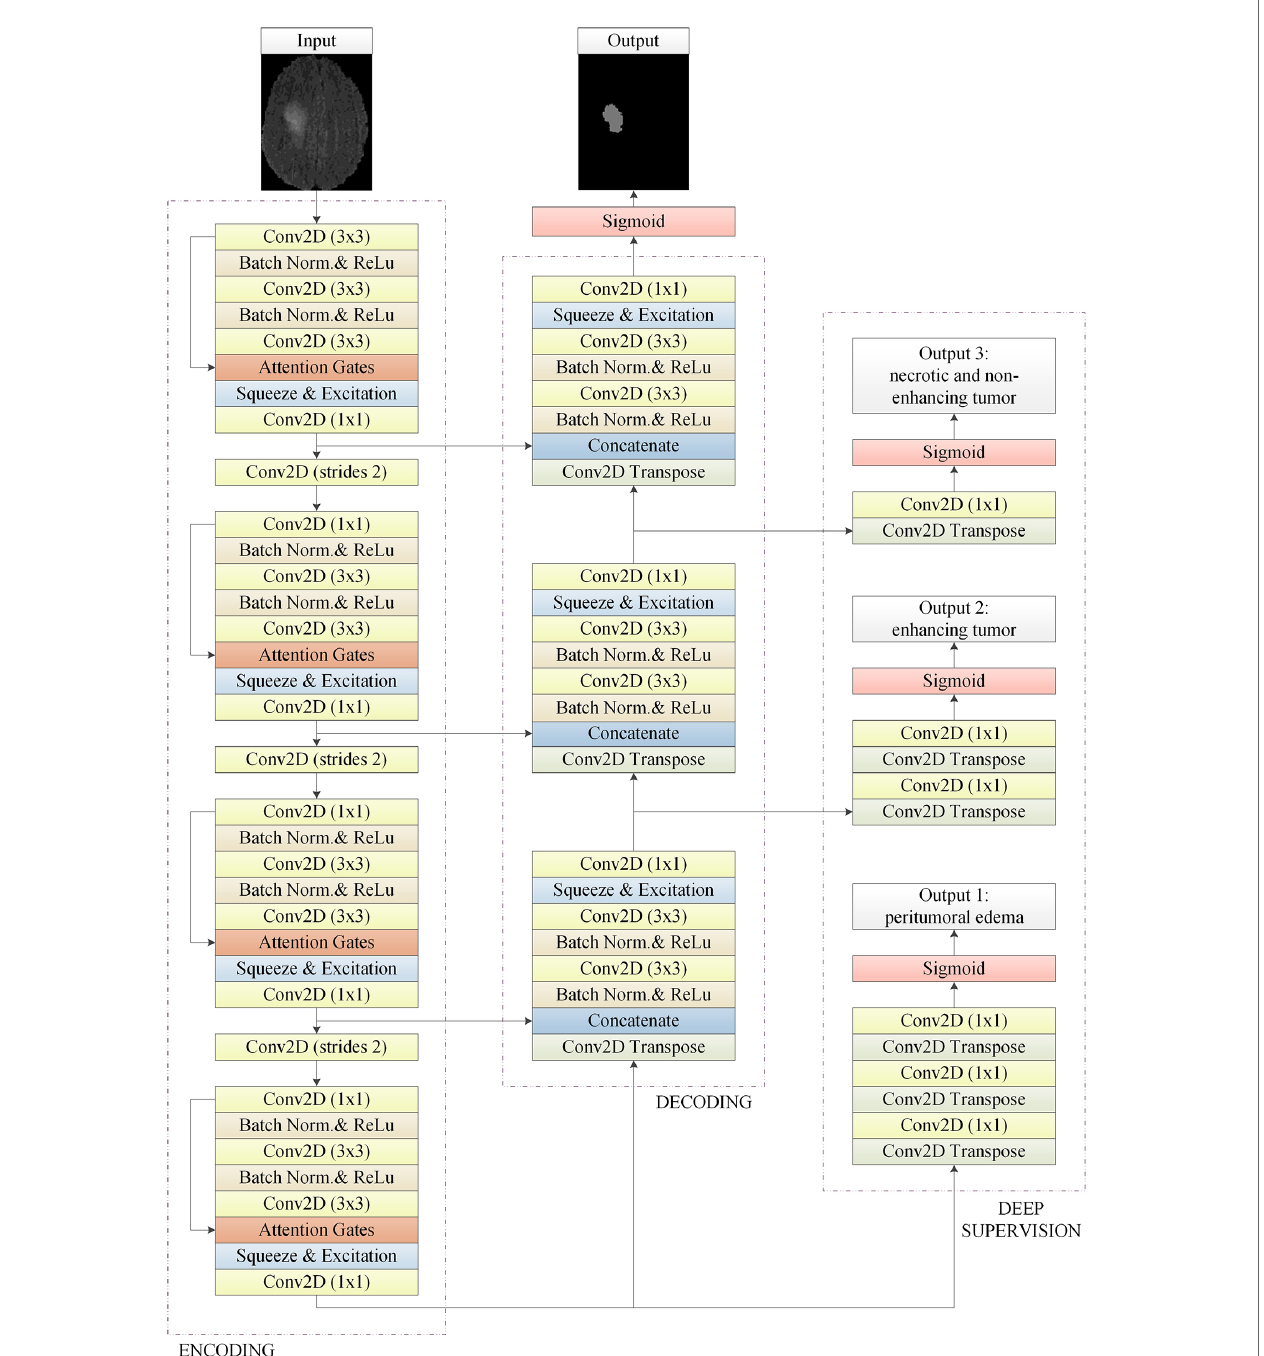
FIGURE 1 | The basic 2D convolutional neural network for brain tumor segmentation. It consists of encoding, decoding, and deep supervision. Our approach is an end-to-end network, the input of the network is a 2D image composed of four modes, and the output is the whole brain tumor prediction result of each 2D image. Output1, output2, and output3 are the subregions of the brain tumors, which are the peritumoral edema, enhancing tumor, and the necrotic and the non-enhancing tumor, respectively. Multi-task deep supervision with progressive relationships can help our method accurately extract the visual features of each